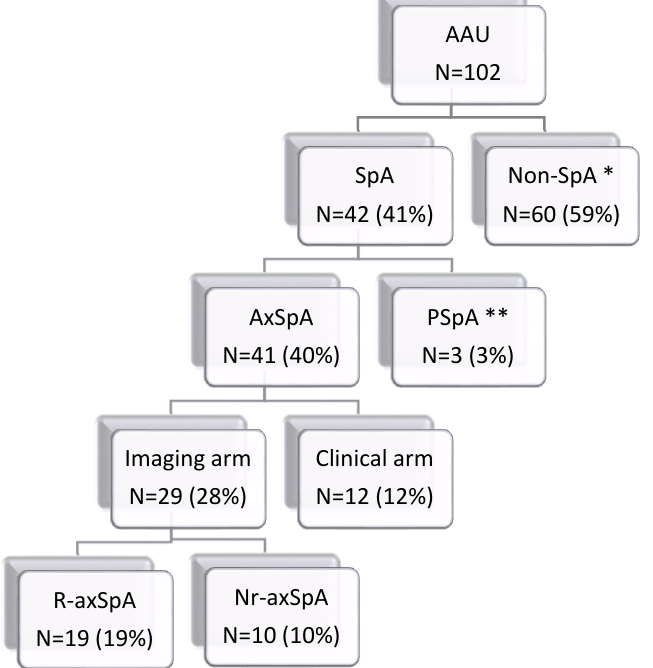
Figure 1. Distribution of patients with acute anterior uveitis according to ASAS classification criteria for axial and peripheral spondyloarthritis. Abbreviations: AAU, anterior uveitis patients; SpA, spondyloarthritis; AxSpA, axial spondyloarthritis; PSpA, peripheral spondyloarthritis; R-axSpA, radiographic axSpA, nr-axSpA, non-radiographic axSpA; * including six patients with sacroiliitis lacking back pain; ** two patients fulfilled both axial and peripheral axSpA.